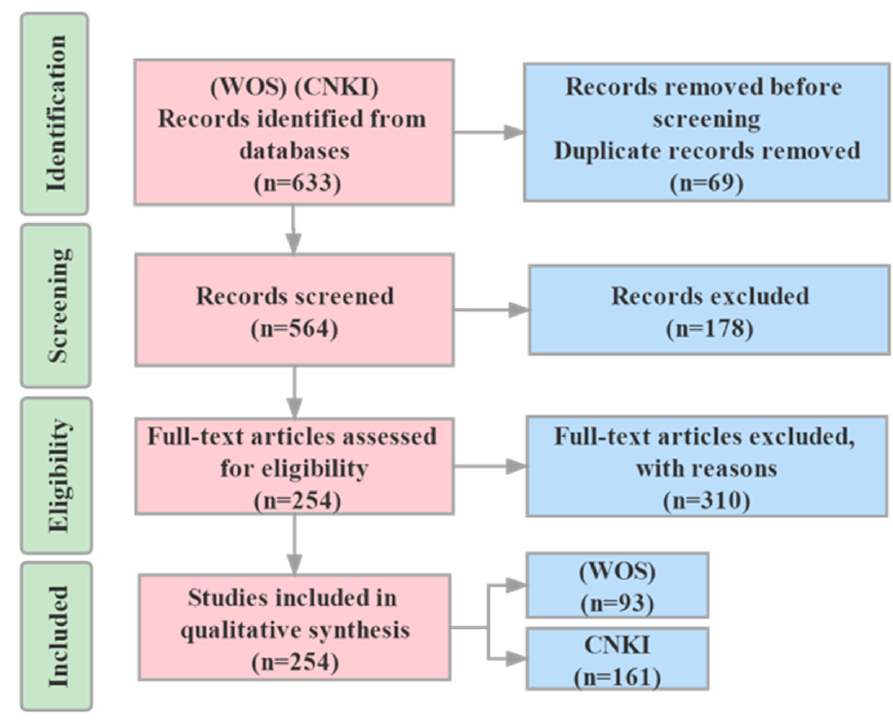
Figure 1. The process of the literature search.